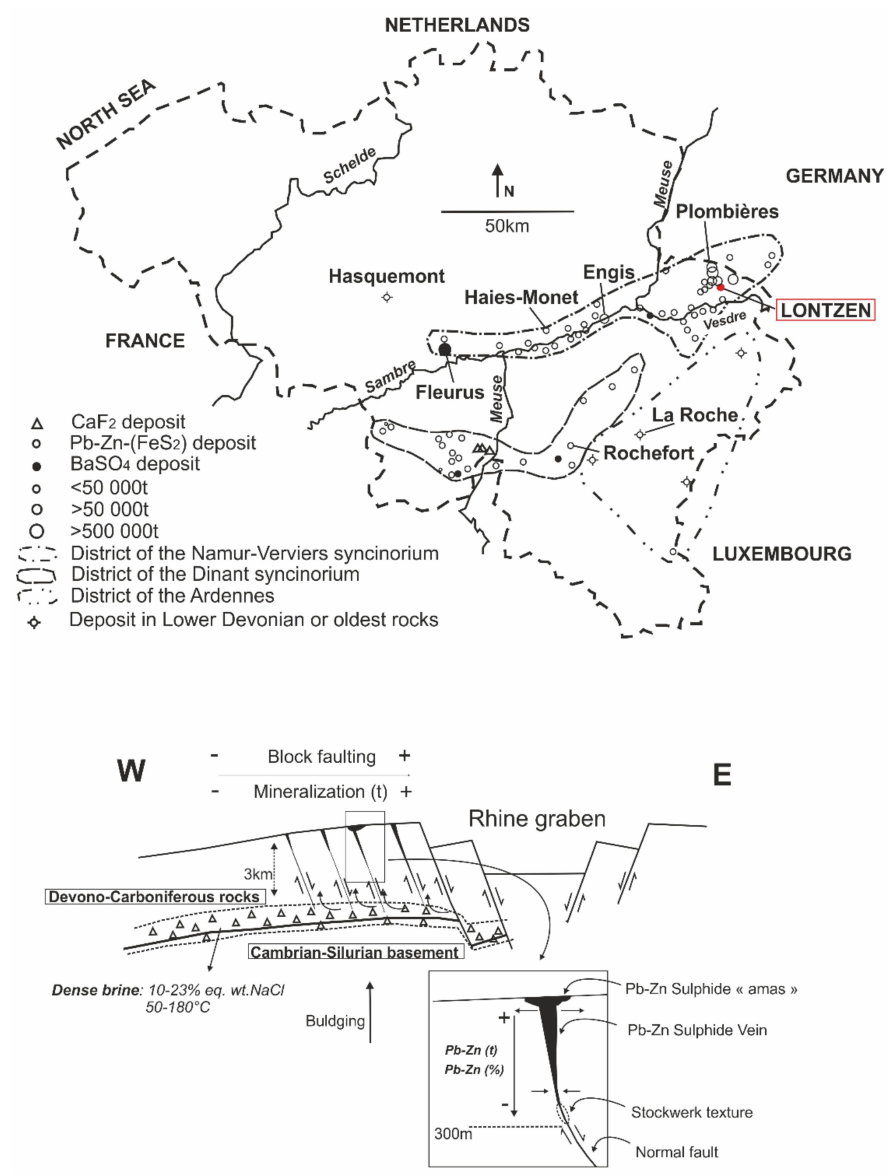
Figure 2. Location of the Belgian Mississippi Valley Type (MVT) ore deposit ( top ) (modified after [23]) and their formation process (after [23–29]) ( bottom